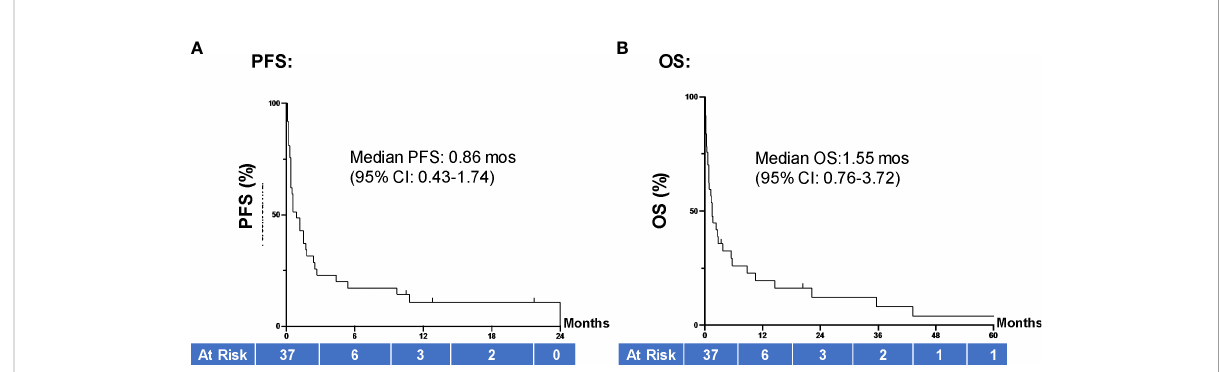
FIGURE 2 PFS and OS of all hospitalized cancer pts. (A) Median PFS for all patients in our study (N=37) was 0.86 months (95% CI 0.43, 1.74) and (B) median OS was 1.55 (95% CI 0.76, 3.72) months. Groups were compared using the log-rank test. Tick marks indicate censored data. P<0.05 indicates statistical signi fi cance. PFS, progression free survival; OS, overall survival.